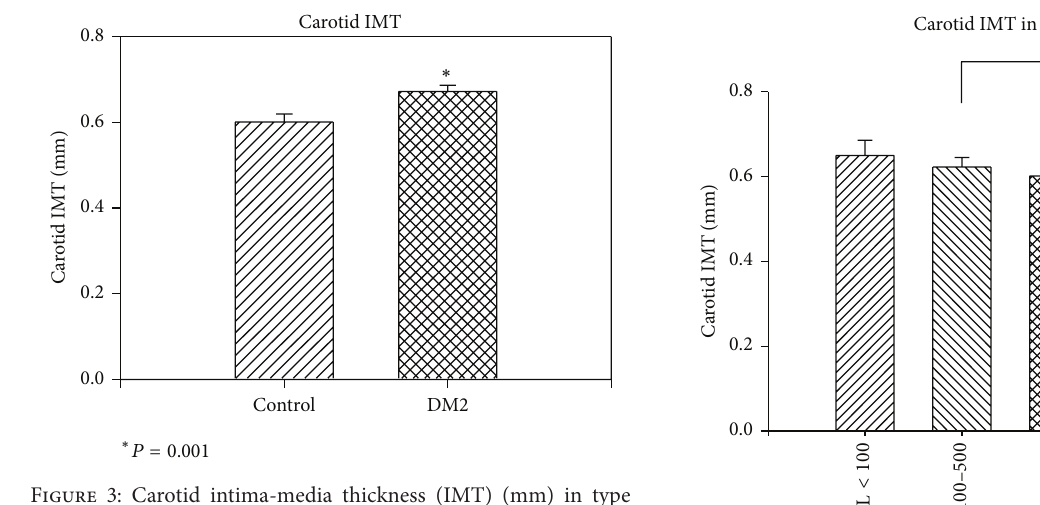
Figure 3: Carotid intima-media thickness (IMT) (mm) in type 2 diabetic patients and controls. IMT was significantly higher in T2DM patients ( 0.672 ± 0.148 ) than in controls ( 0.602 ± 0.128 ) ( 𝑃 = 0.001 ).